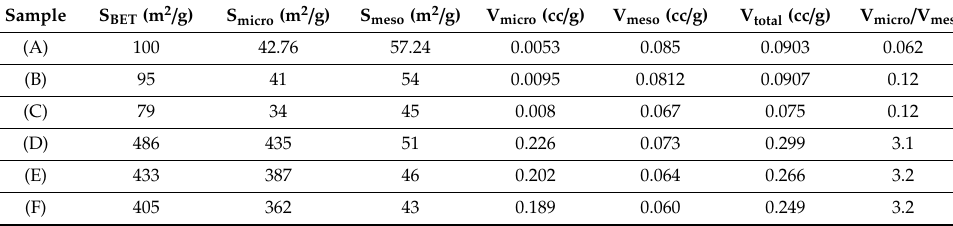
Table 4. Porous Structure Characteristics.